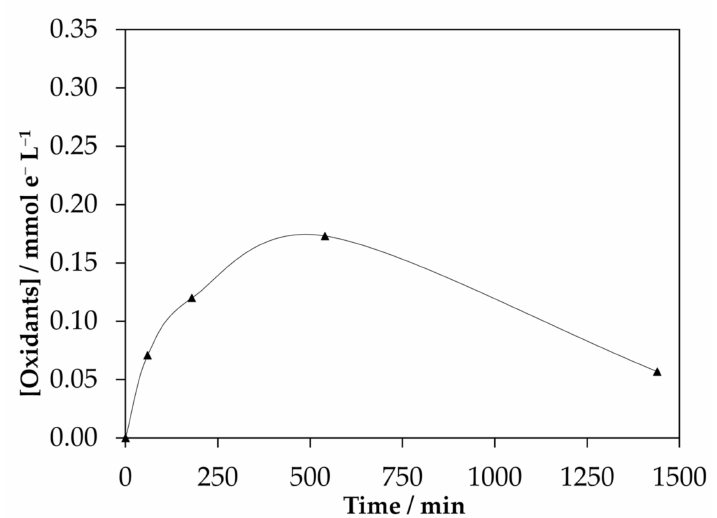
Figure 3. Concentration of total oxidants in the gas phase.